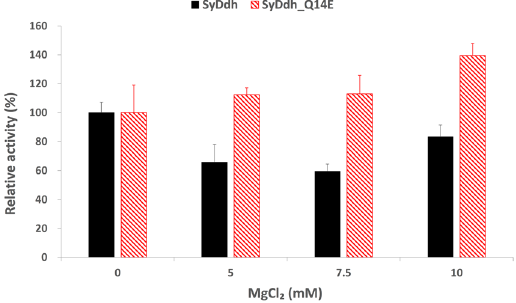
Figure 6. Enzymatic assay of Sy Ddh and Sy Ddh_Q14E with different Mg 2 + concentrations. The graphs show the mean ± SD obtained from three independent experiments. For the enzyme assay, 60 pmol of Sy Ddhs was used. Each activity of Sy Ddhs in the absence of effectors was set at 100%.